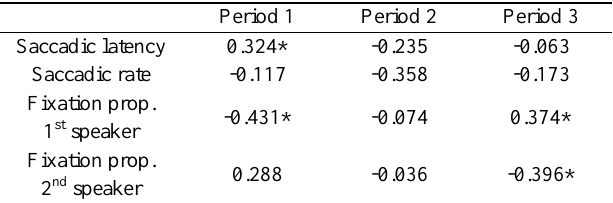
Pearson correlations between eye-movement measures and BDI-II